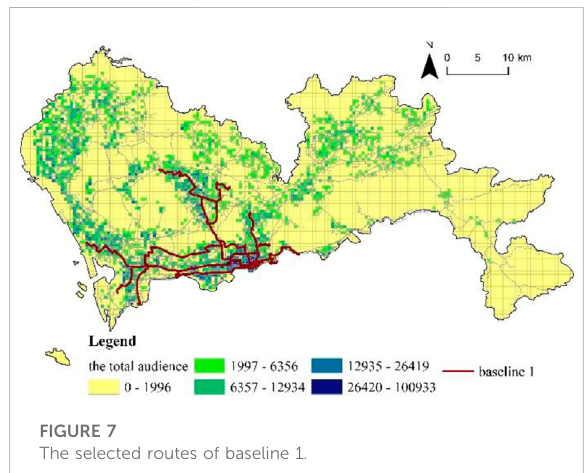
FIGURE 7 The selected routes of baseline